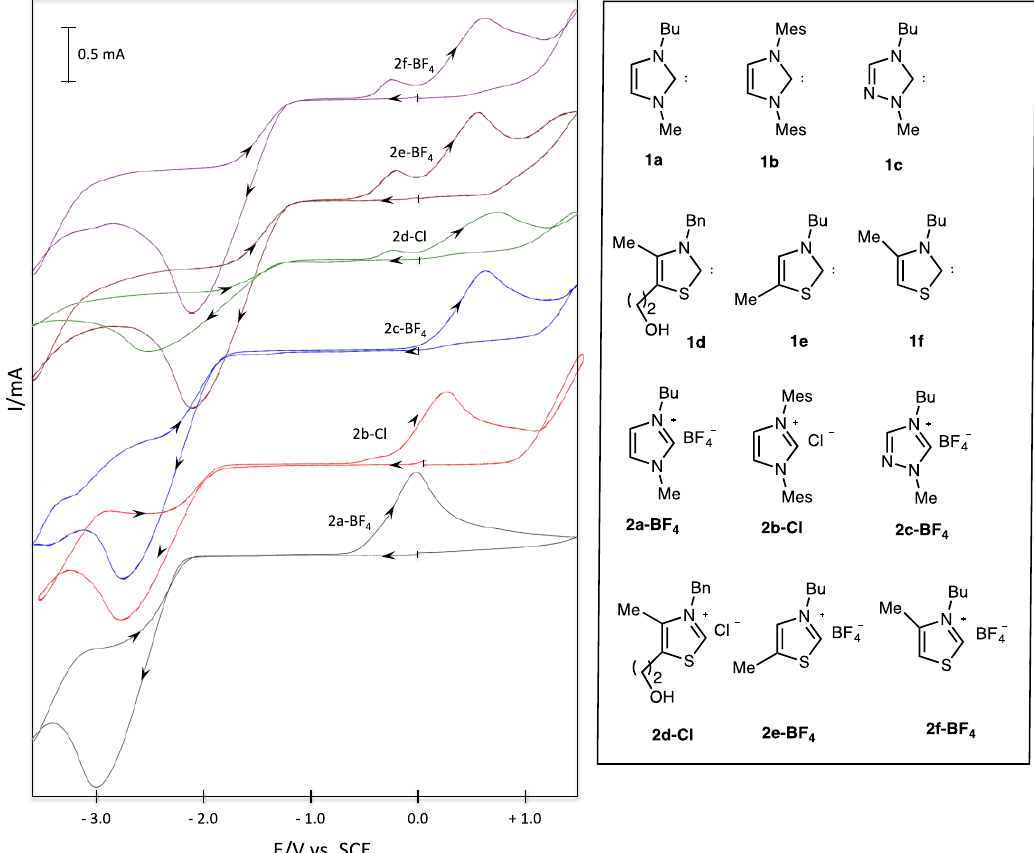
Figure 7. Cyclic voltammetries of DMF solutions of azolium salts (0.1 M). Vitreous carbon cathode, ν = 0.2 V·s −1 , T = 25 °C. Scan potential: 0.0 to −3.6 to +1.5 to 0.0 V vs. SCE. Reproduced with permission from [32]. Copyright Wiley-VCH, 2016.